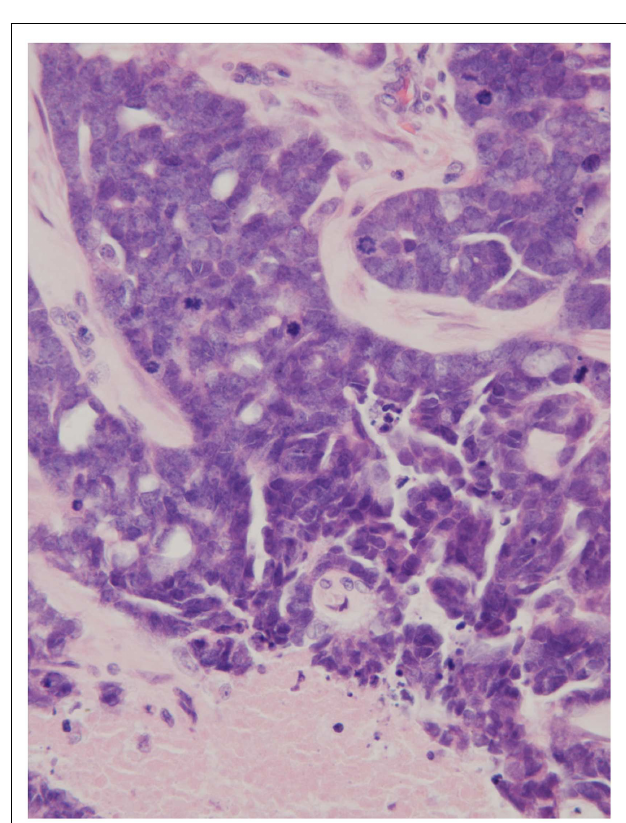
FIGURE 2 | Node histology ( × 250) demonstrating necrotic tissue, an abundance of mitotic figures, and the impression of glandular architecture (H&E)